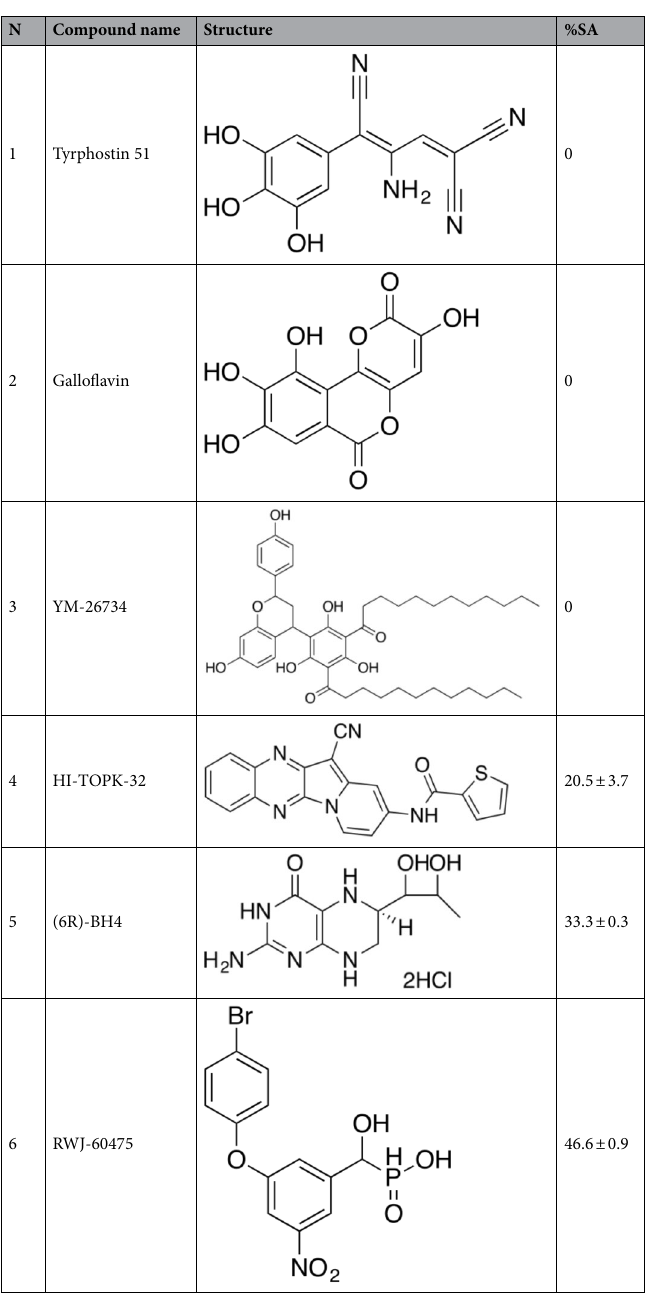
Table 2. Hits identified in primary screen. Percentage specific activity (SA) of compounds tested against SapM at 100 µM. Values are average ± SD of